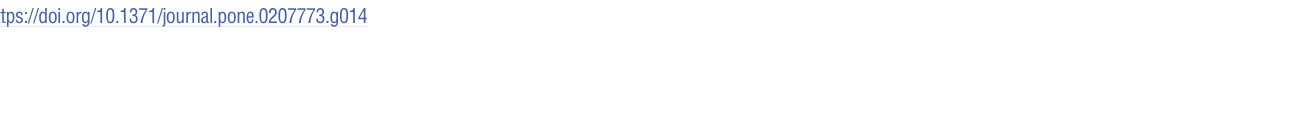
PLOS ONE | https://doi.org/10.1371/journal.pone.0207773 December12,